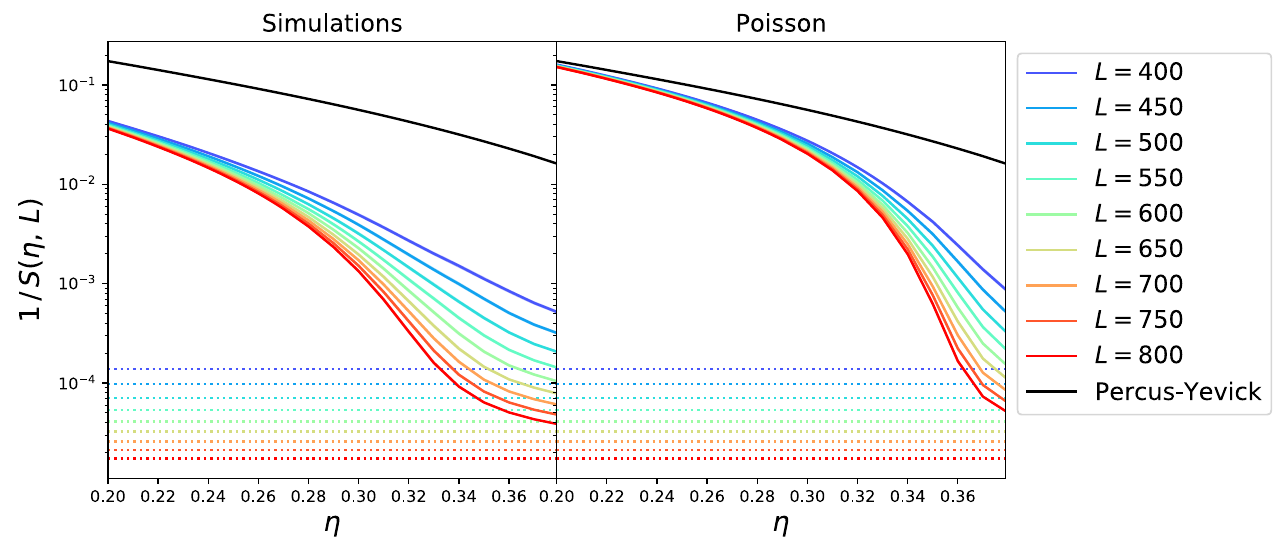
FIG. 8. Mean number of particles per cluster S ð η ; L Þ , as a function of the reduced density η and (cubic) simulation box size L . We show results for both cosmological data and Poisson realizations, plotting the reciprocal 1 =S ð η ; L Þ averaged over 1000 realizations. Note that S ð η Þ is bounded by the number of particles in the dataset ( N ), shown by dotted lines. We additionally show the Percus-Yevick prediction in black, which is inaccurate for all but the smallest η